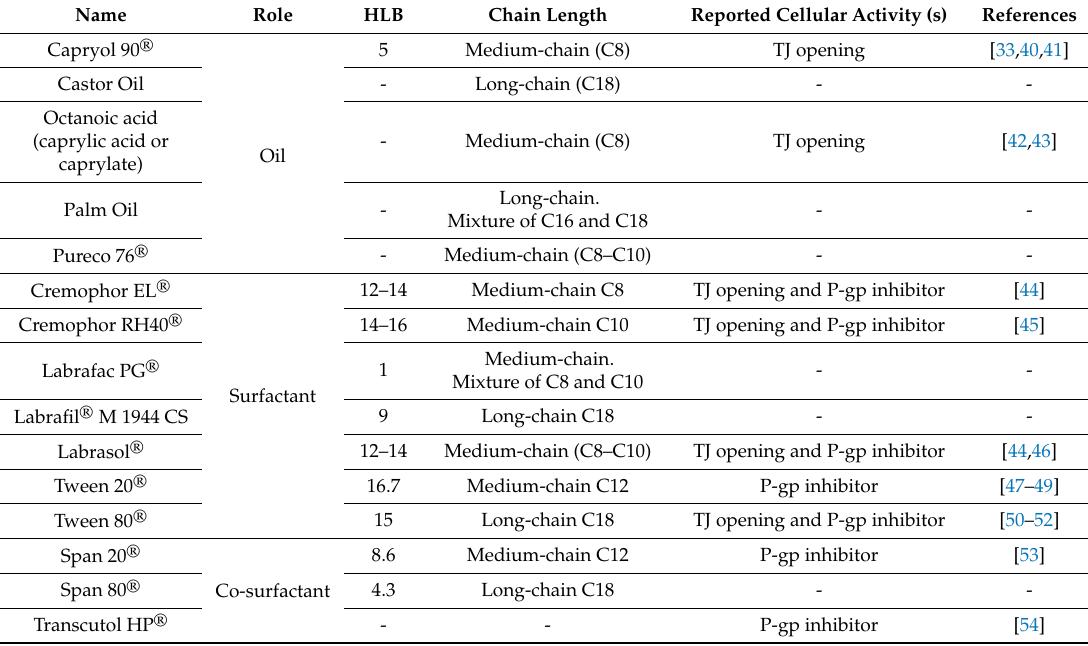
Table 1. Screened excipients’ role, characteristics, and previously reported cellular